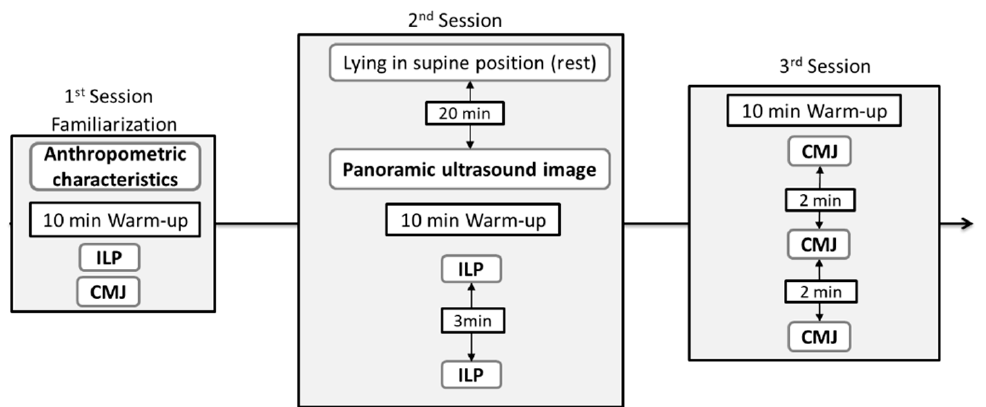
Figure 1. Schematic representation of the study protocol, ILP: isometric leg press, CMJ: countermovement jump.